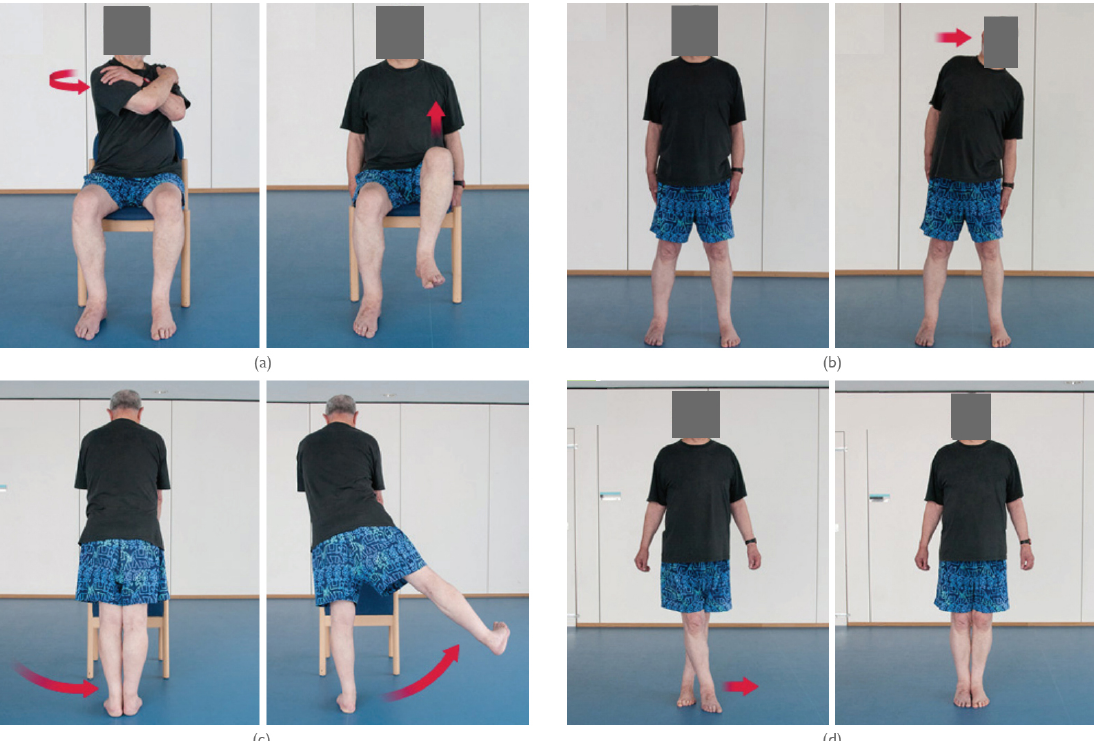
Figure 3. A sample of exercises recommended by National Health Services in the UK for older adults: ( a ) sitting exercises; ( b ) flexibility exercises; ( c ) strength exercises; and ( d ) balance